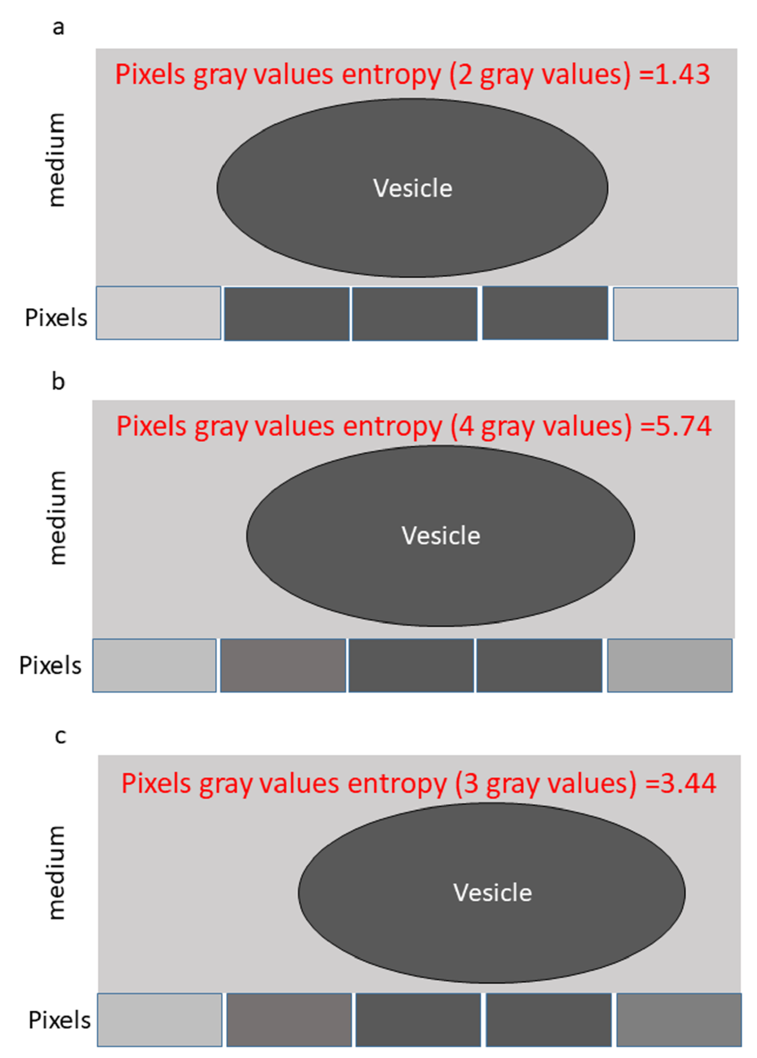
Figure 1. An example of a particle motion captured by five pixels in a homogenous medium. ( a ) The particle is located in the center, covers the length of the three central pixels. Accordingly, the five pixels present two gray levels and information entropy of 1.43. ( b ) The particle moves a length of 0.25 pixel to the right. In this situation, it fully covers the length of 2 pixels, partially and di ff erently covers the length of two other pixels and does not cover one pixel. Accordingly, the five pixels present four gray levels and information entropy of 5.74. ( c ) The particle moves a length of 0.5 pixel to the right. In that situation, it fully covers the length of two pixels, partially and similarly covers the length of two other pixels and does not cover one pixel. Accordingly, the five pixels present three gray levels and information entropy of